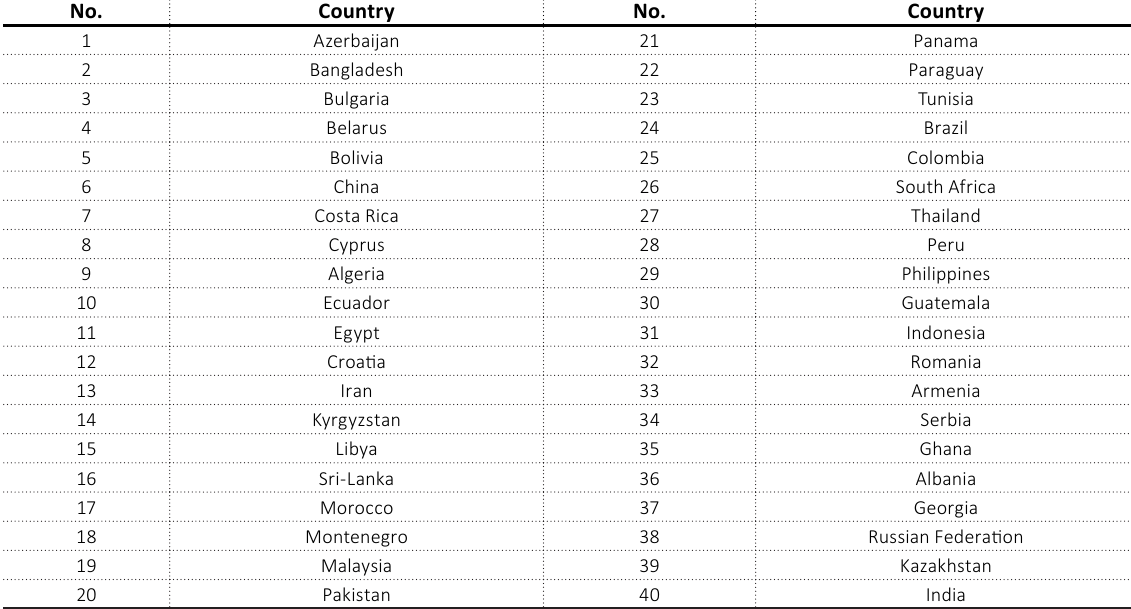
Table A1. The sample of 40 emerging market